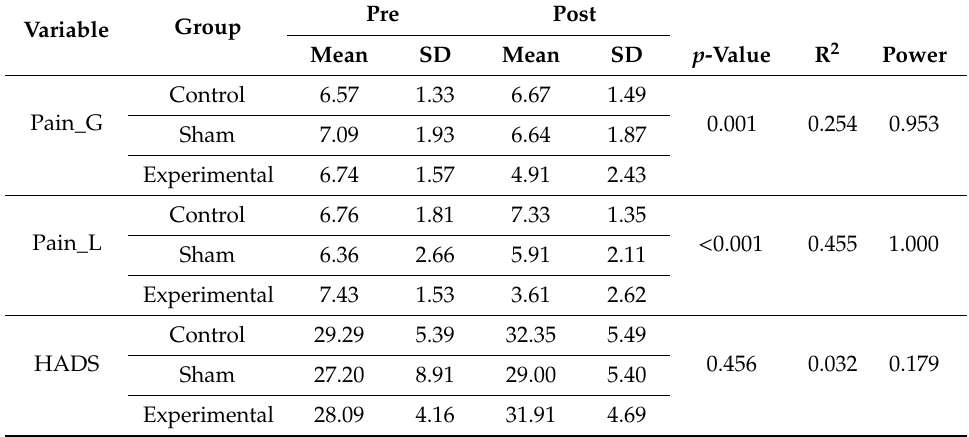
Table 2. Scores of the groups in the outcomes variables and results of the analysis of covariance using height as a covariable.